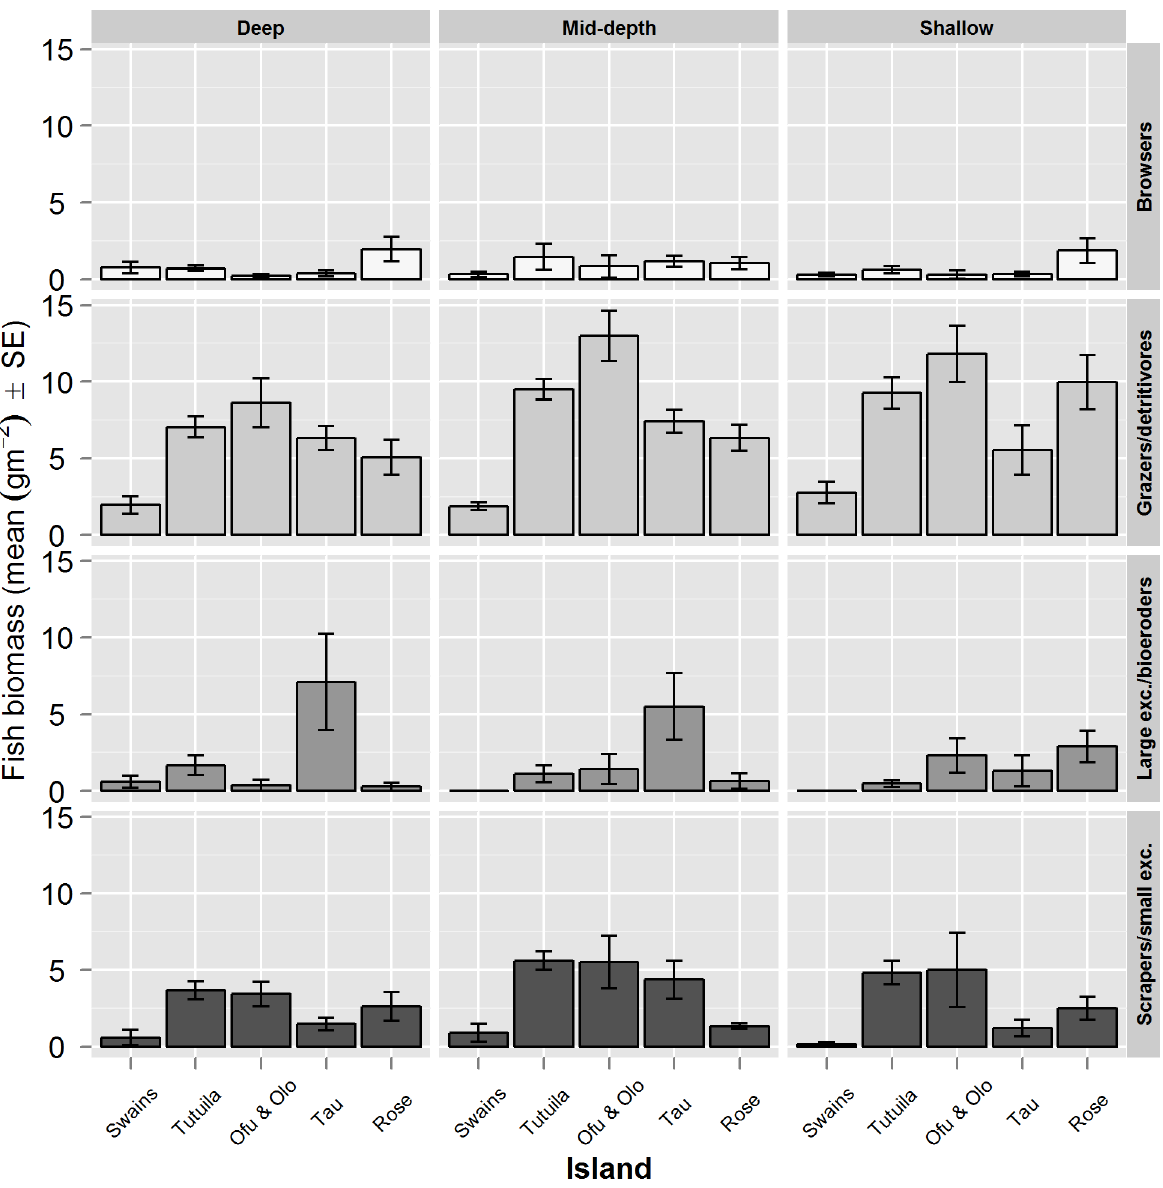
Figure 3. Variation in the biomass of functional groups of herbivorous reef fishes in American Samoa. The mean biomass (gm 2 2 ) (SE) of A) browsers, B) grazers/detritivores, C) large excavators/bio-eroders and D) scrapers/small excavators per island. Mean biomass per groups was calculated by pooling all sites surveyed per island. Ofu & Olo=Ofu & Olosega.